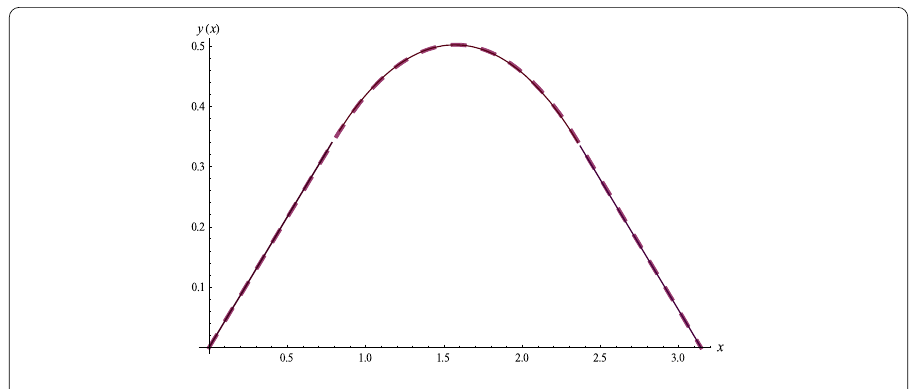
Figure 1 The RK approximate solutions of BVP (4.3) at α = 1